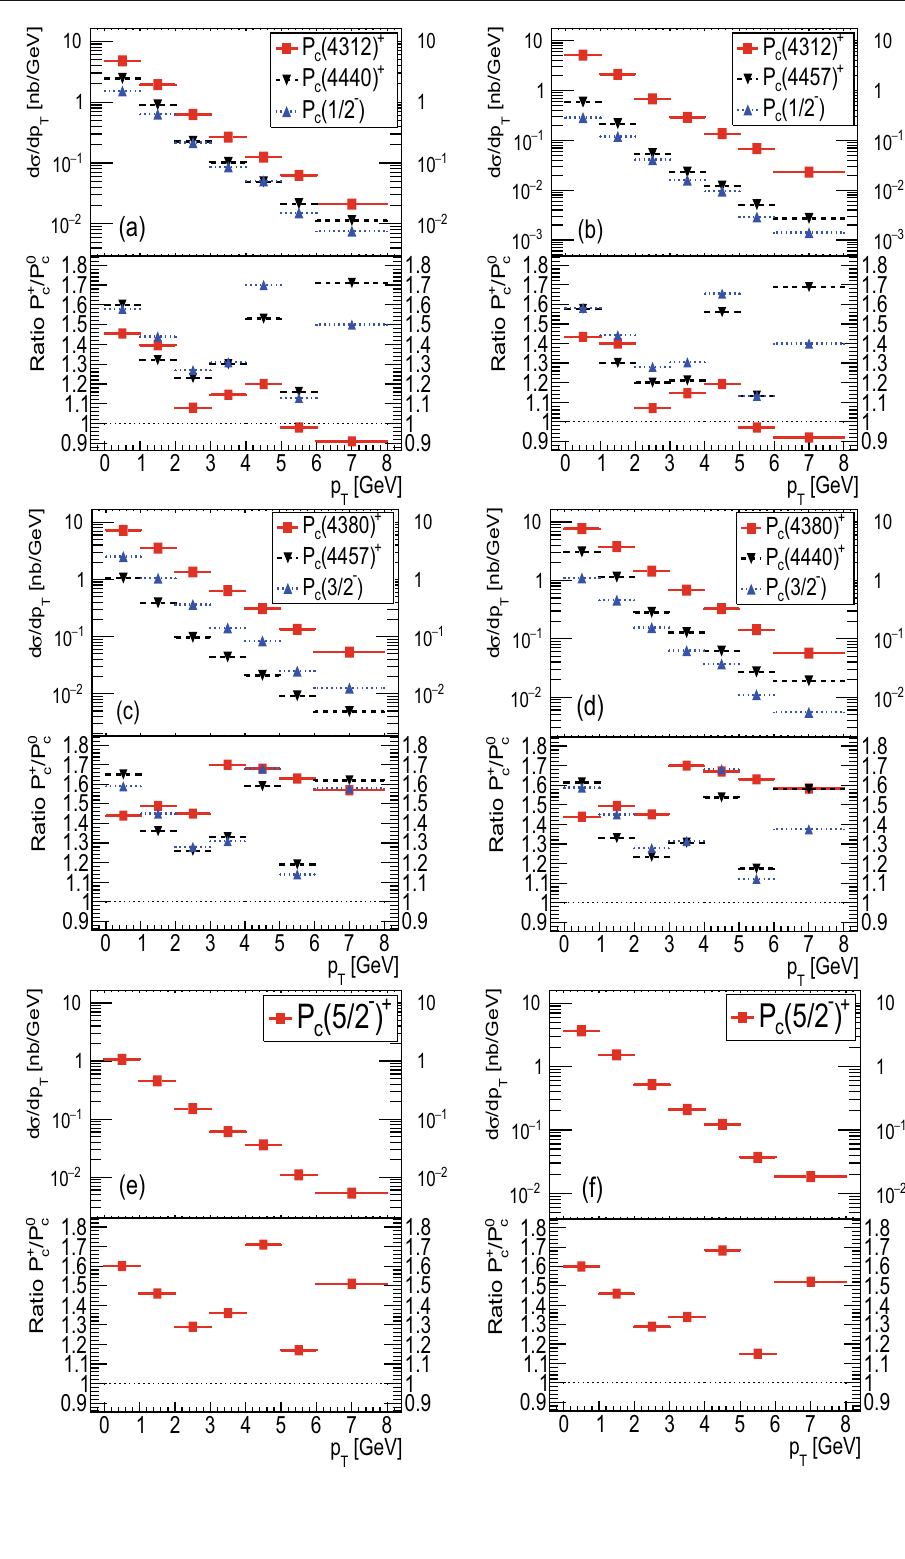
Fig. 4 The cross sections of the inclusive charged hidden charm pentaquarks, i.e. the charged P + c s, in pp collision at √ s = 7 TeV in terms of the transverse momentum p T with (cid:5) = 0 . 7 GeV. Their ratios relative to the neutral ones, as defined in Eq. (12), are also presented below each figure. The three figures on the left ( a , c , e ) and right ( b , d , f ) hand sides are for the solution A and B in Ref. [67], respectively. Figures a , b are for the P c s with − quantum number J P = 1 2